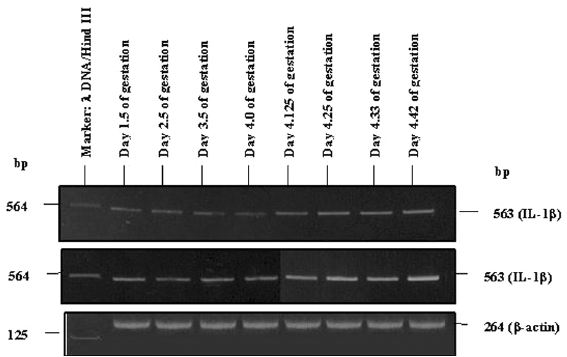
Figure 3. Detection of IL-1 b mRNA transcripts in the pre- implantation mouse embryos collected from (a) control animals, (b) animals treated with LPS at the different stages of preimplan- tation period of pregnancy by RT-PCR. Panel (c) shows the uniform expression of b -actin used as a positive control.